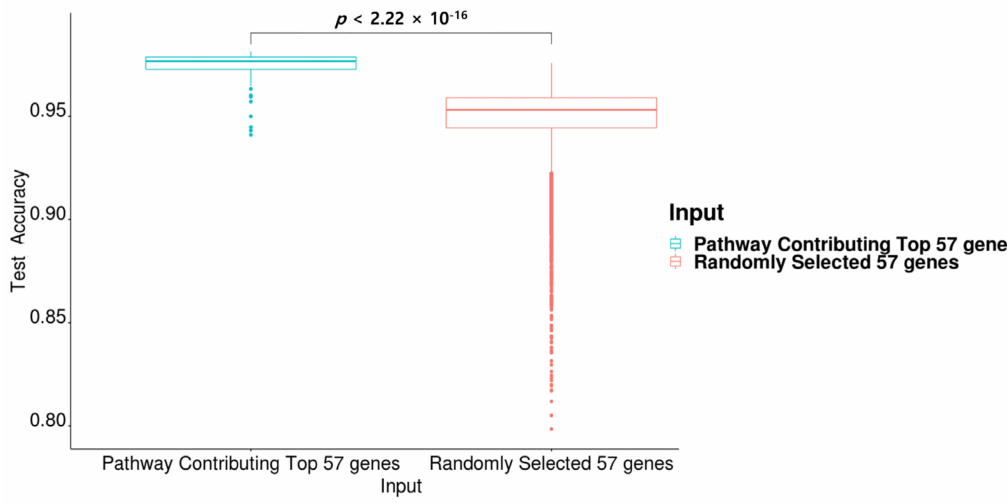
Figure 5. Performance comparison between pathway contribution of the top 57 genes and a randomly selected 57